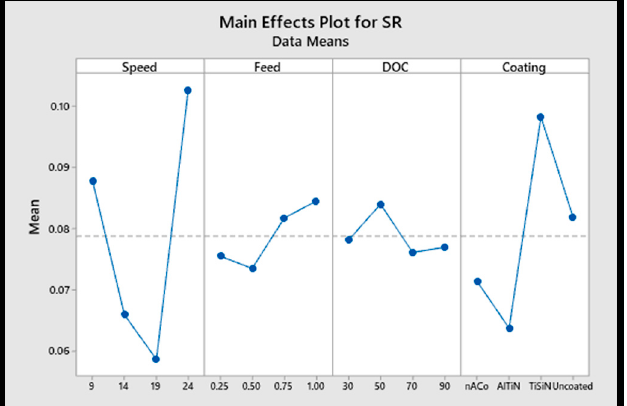
Figure 4. Surface roughness as a function of tool coating and cutting parameter.